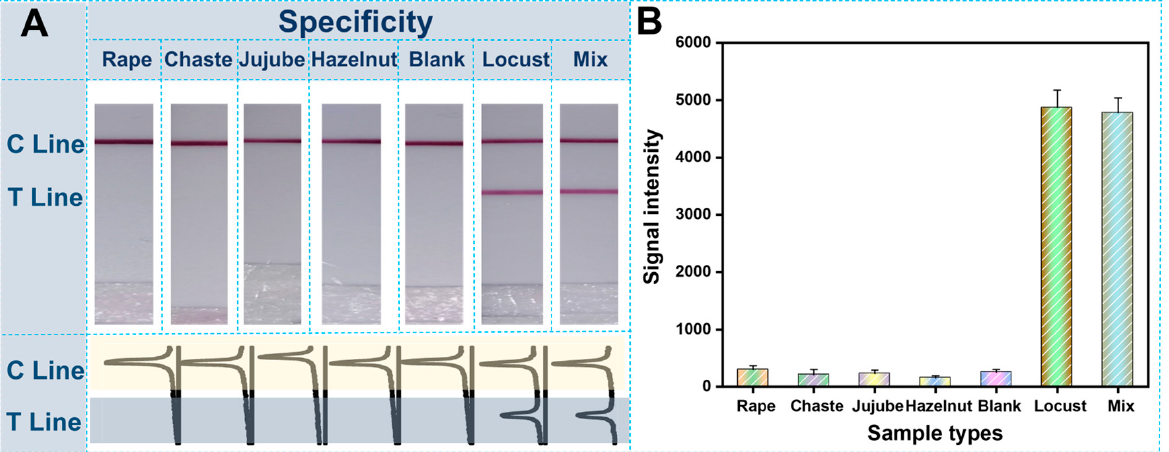
Figure 5. Selectivity assay results of the amplification-assisted molecular LFS: ( A ) Visual observation results of amplification-assisted molecular LFS and corresponding curves of ImageJ treated results; ( B ) Quantitative analysis results of ImageJ treated results.